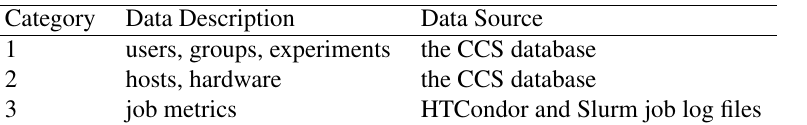
Table 1: Data categories collected by the acquisition layer.